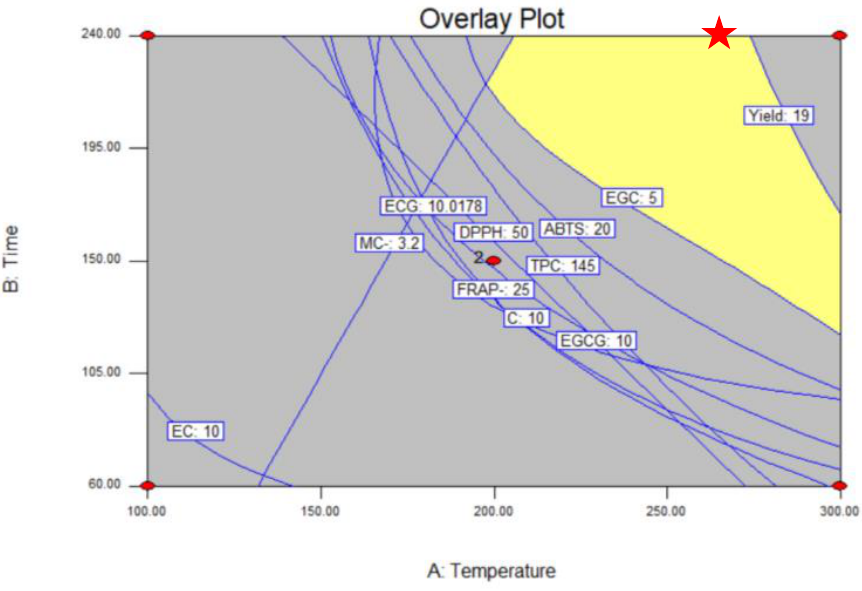
Figure 3. Response surface plots of optimized condition. The plots show the effect of roasting temperature and roasting time : optimum point.